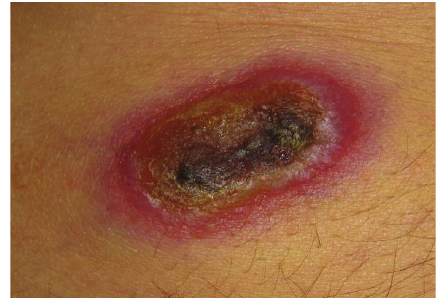
Figure 1: Crusted, raised skin lesion with regular